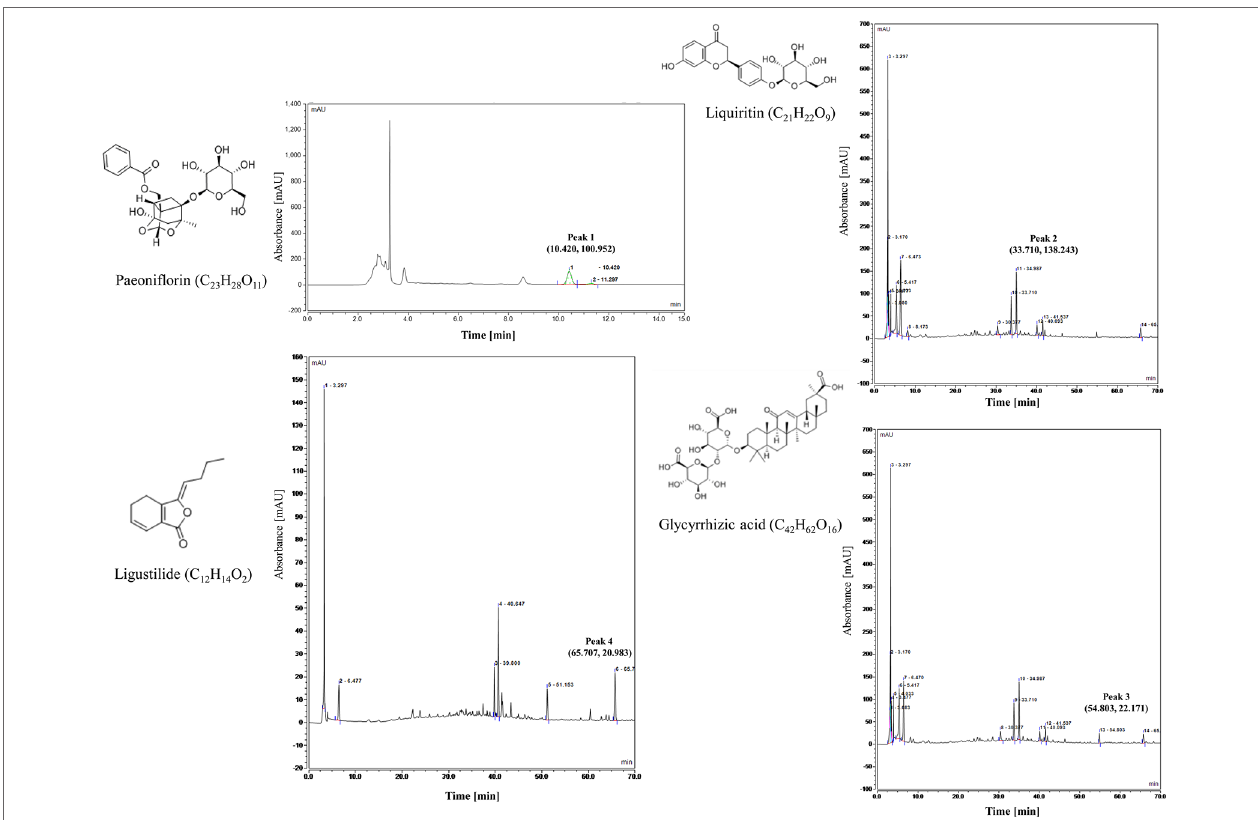
FIgURe 1 | Control characteristic map (chromatogram) of Xiaoyao Pills (peak 1, peak 2, peak 3, peak 4 represent peak characteristic of Paeoniflorin, Liquiritin, Glycyrrhizic acid, Ligustilide, respectively.).